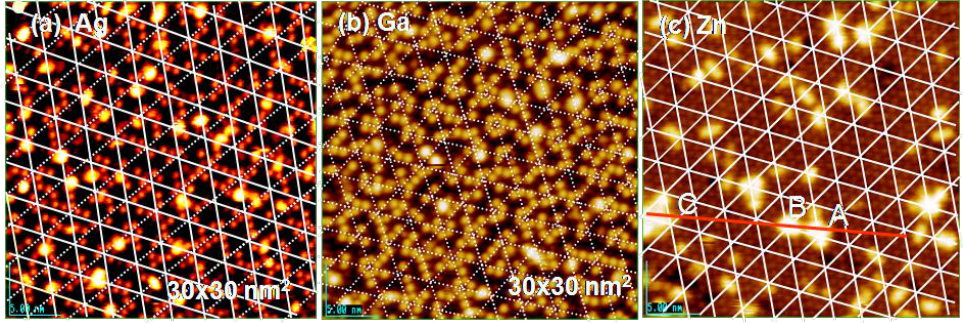
Figure 20. Single atom of Ag, Ga, and Zn adsorbed on a Si(111)-7 × 7-C ( a ) Ag-atoms are stabilized on either corner or center Si-adatoms; ( b ) Ga-atoms are stabilized on corner Si-adatoms, and ( c ) Zn-atoms prefers to form pairs on two neighboring Si-adatoms